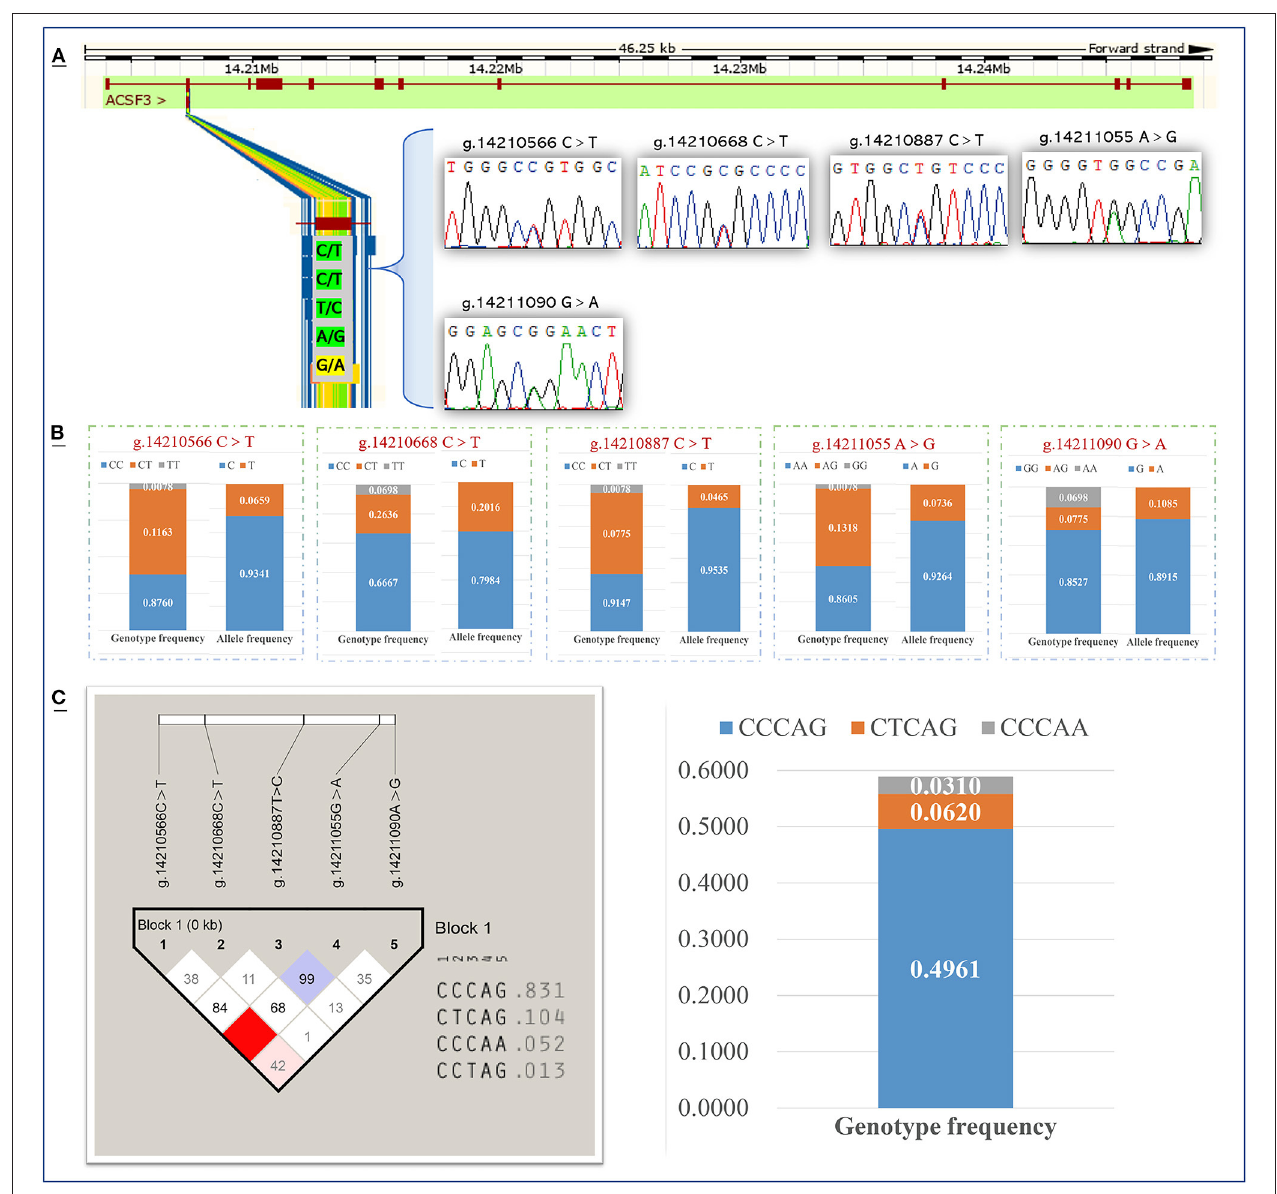
FIGURE 4 | Detection and genotyping of Single-nucleotide polymorphism sites of the ACSF3 gene in Chinese Simmental cattle. (A) Identify five SNPs in the second exon of the ACSF3 gene. (B) Gene frequency and genotype frequency of five SNPs of ACSF3 gene. (C) The haplotypes composed of five SNPs of ACSF3 gene and the frequency analysis of